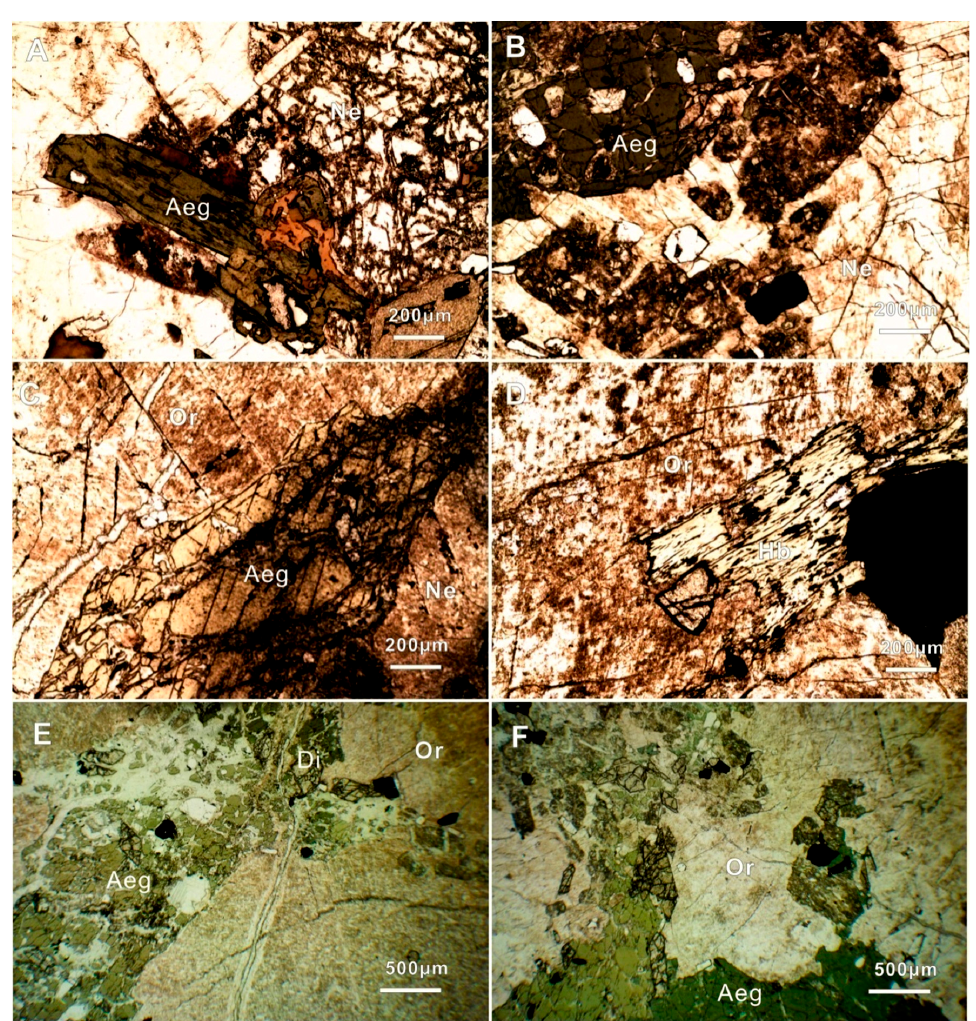
Figure 4. Thin section photomicrographs of ( A , B ) mosaic textures with the assemblage aegirine + nepheline + orthoclase of aegirine-nepheline syenite, nepheline was subjected to alteration. ( C ) Aegirine-nepheline syenite with porphyric texture, consisting of aegirite, nepheline, orthoclase. ( D ) Mosaic texture with the orthoclase + hornblende of alkaline syenite. Abbreviations are Aeg: aegirine; Di: diopside; Hb: hornblende; Ne: nepheline; Or: orthoclase. ( E ) Aegirite bonded with diopside in the